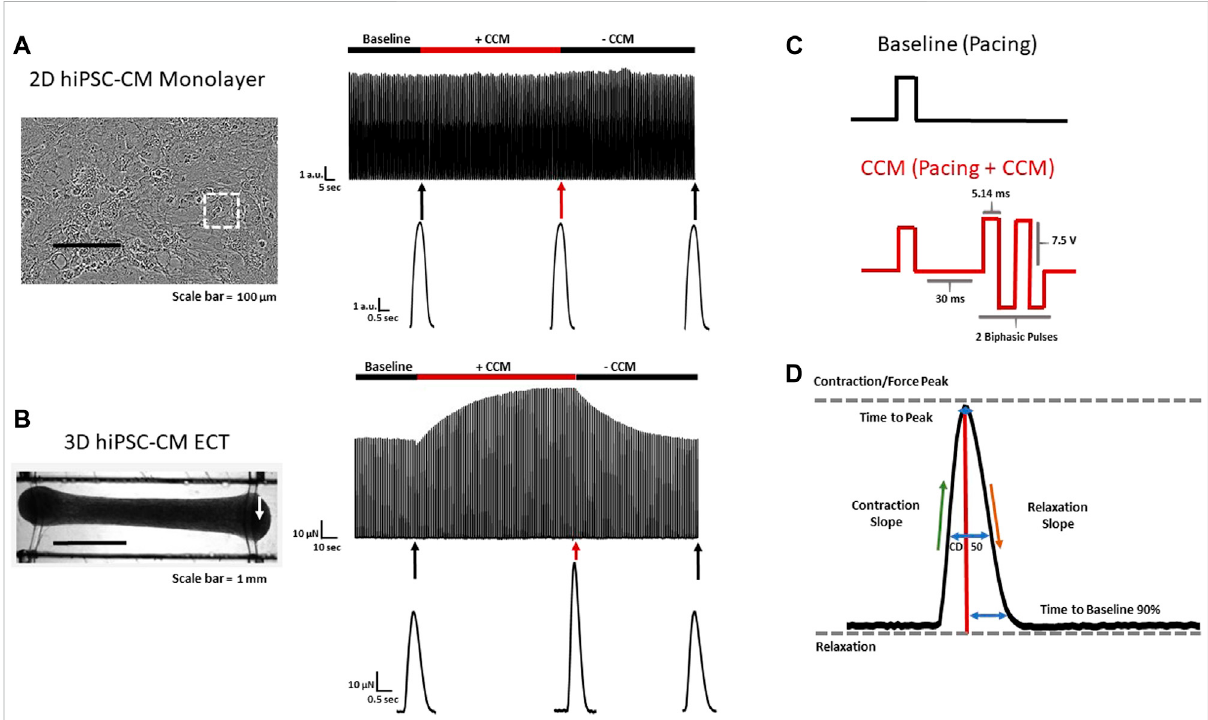
FIGURE 1 2D and 3D hiPSC-CM CCM models (A) Effect of standard clinical CCM signal on conventional 2D (stiff substrate) and (B) 3D ECT hiPSC-CM models.RepresentativecontractionrecordingsbeforeCCM(Baseline),duringCCM(7.5 V)andafterCCM(recovery)in2DhiPSC-CMmonolayerand 3D ECT. 3D ECTs displaying enhanced CCM-induced force. White arrow indicates edge of 3D ECT where force transducer was connected (C) Baseline (Control) pacing waveform (Top) and standard biphasic CCM waveform (i.e., two biphasic pulse, 7.5 V, 5.14 ms duration, 30 ms delay) (Bottom). (D) Schematic contractility waveform depicting key contractile parameters evaluated. Contraction slope and relaxation slope were calculated as maximum and minimum of the time derivative of the contractility amplitude respectively. White square indicates region of interest of 2D